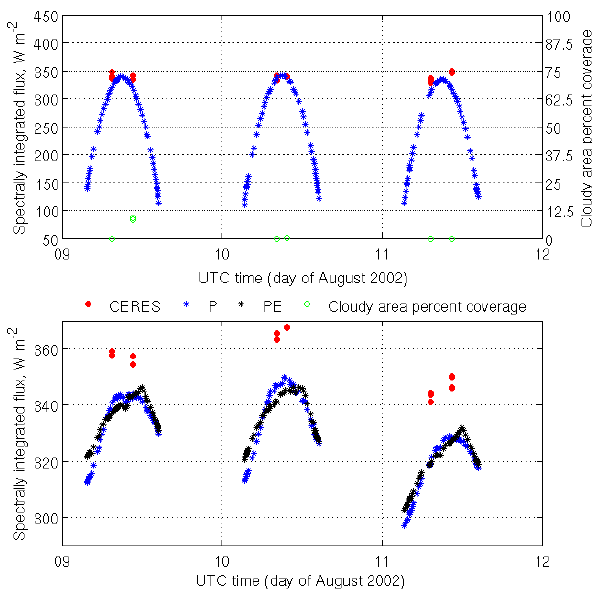
Figure 5. TOA upwelling fluxes at Solar Village. The top (SW) and bottom (LW) panels present fluxes computed with approximated surface temperature (P, blue) and prescribed from ERA-Interim (PE, cyan) and satellite-inferred fluxes (CERES, red). Cloudy area per- cent coverage derived from CERES product (top panel, green) is plotted against the right vertical axis.